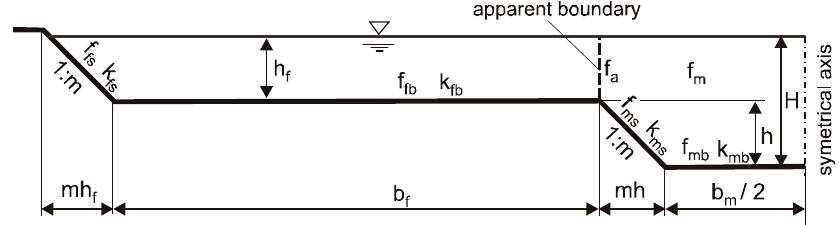
Figure 1. Symbols used for dimensions of the compound cross-section of the channel.